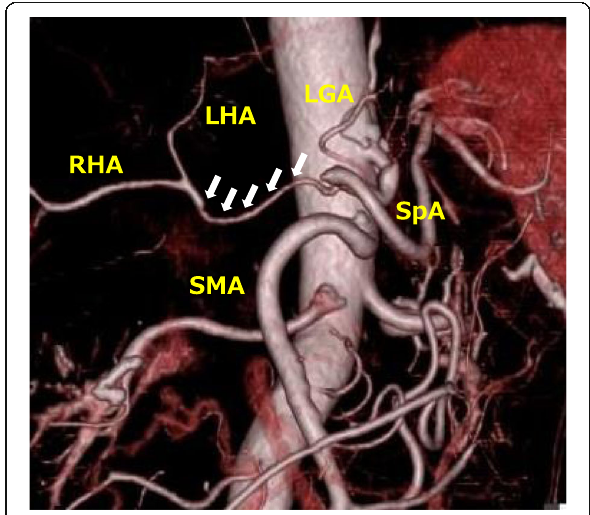
Fig. 4 Follow-up CT angiography at 3 months after surgery demonstrated sufficient hepatic flow through the anastomotic site between the CHA and PHA (white arrow)